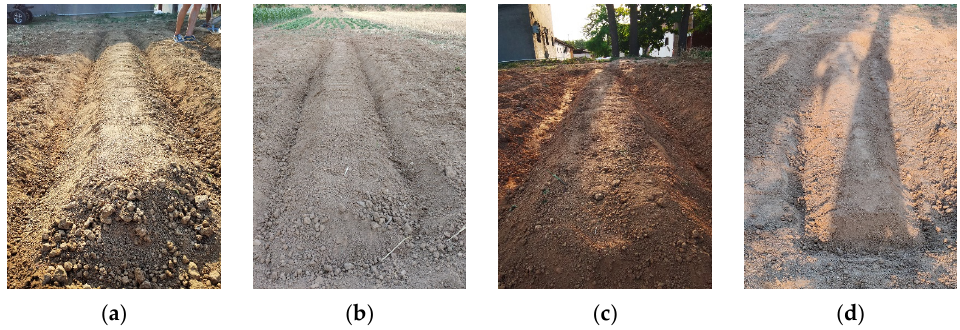
Figure 1. Image acquisition. ( a ) Strong light. ( b ) Low light. ( c ) Shadow. ( d ) Ordinary light.